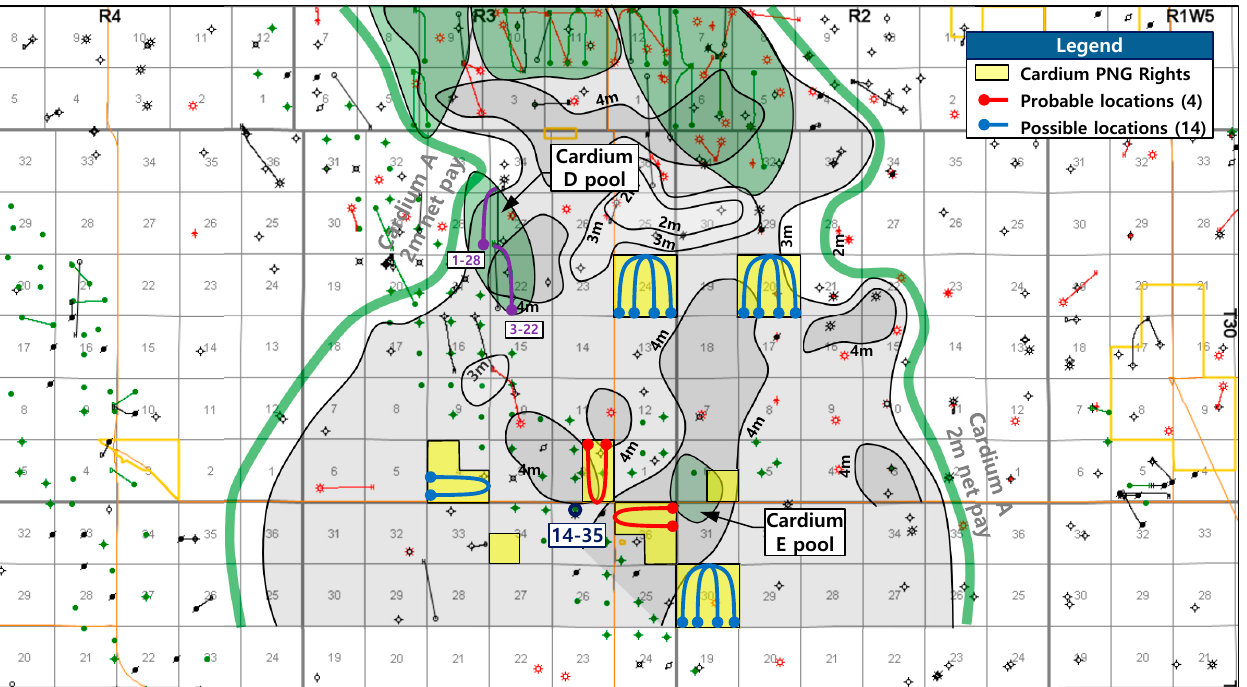
Figure 5. Cardium A development plan by net pay mapping with economic evaluation.